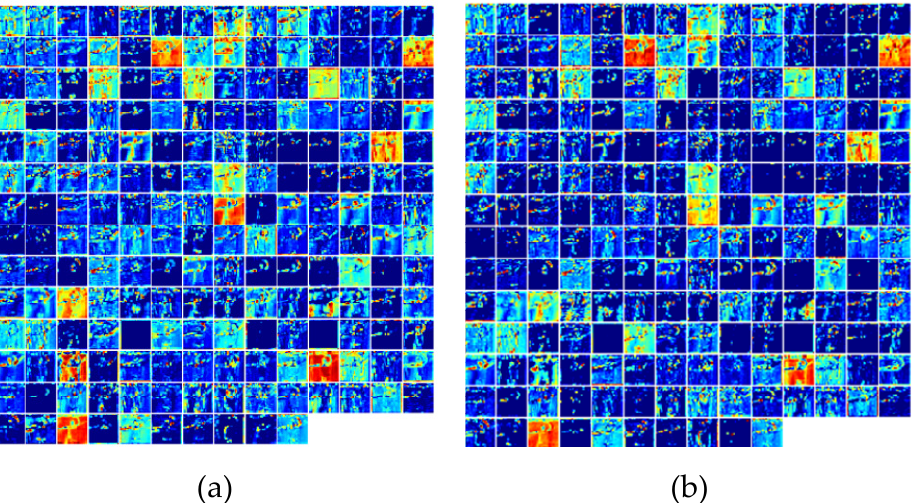
Figure 5. Comparison of channel feature map between DA-3D and MSA-3D: ( a ) features of each channel extracted after the third layer of DA-3D network; ( b ) features of each channel extracted after the third layer of MSA-3D network.